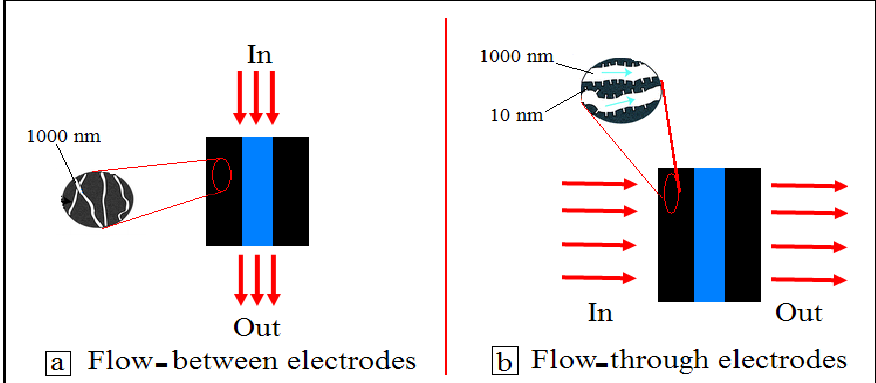
Figure 1. Schematic diagram of flow-between and flow-through electrodes in CDI cells.